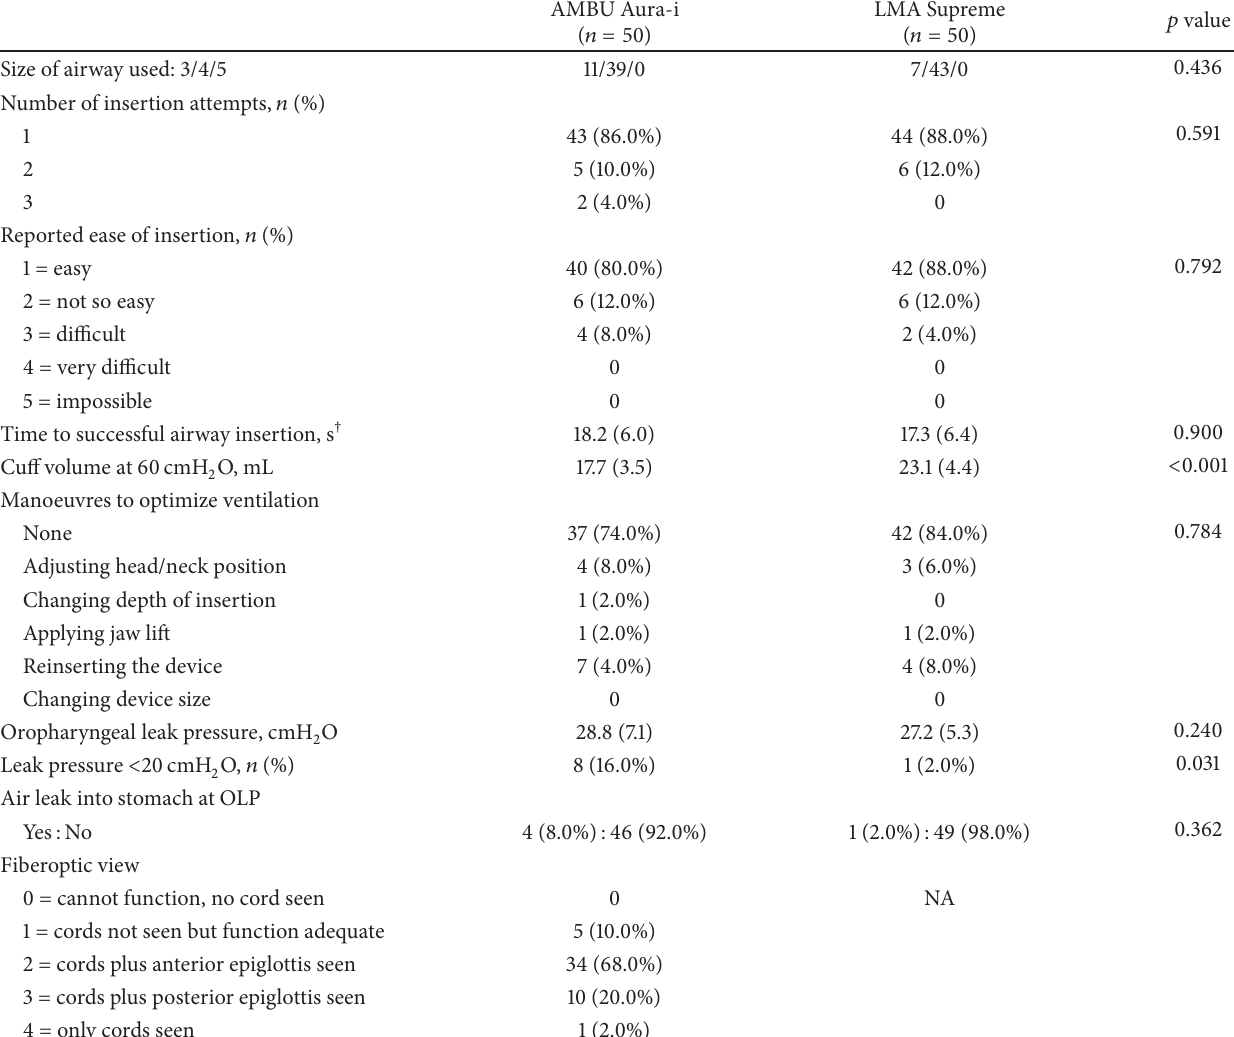
Table 2: Airway insertion characteristics and performance of airway devices. Values are expressed as mean (SD) or numbers of patients ( 𝑛 ) and percentages